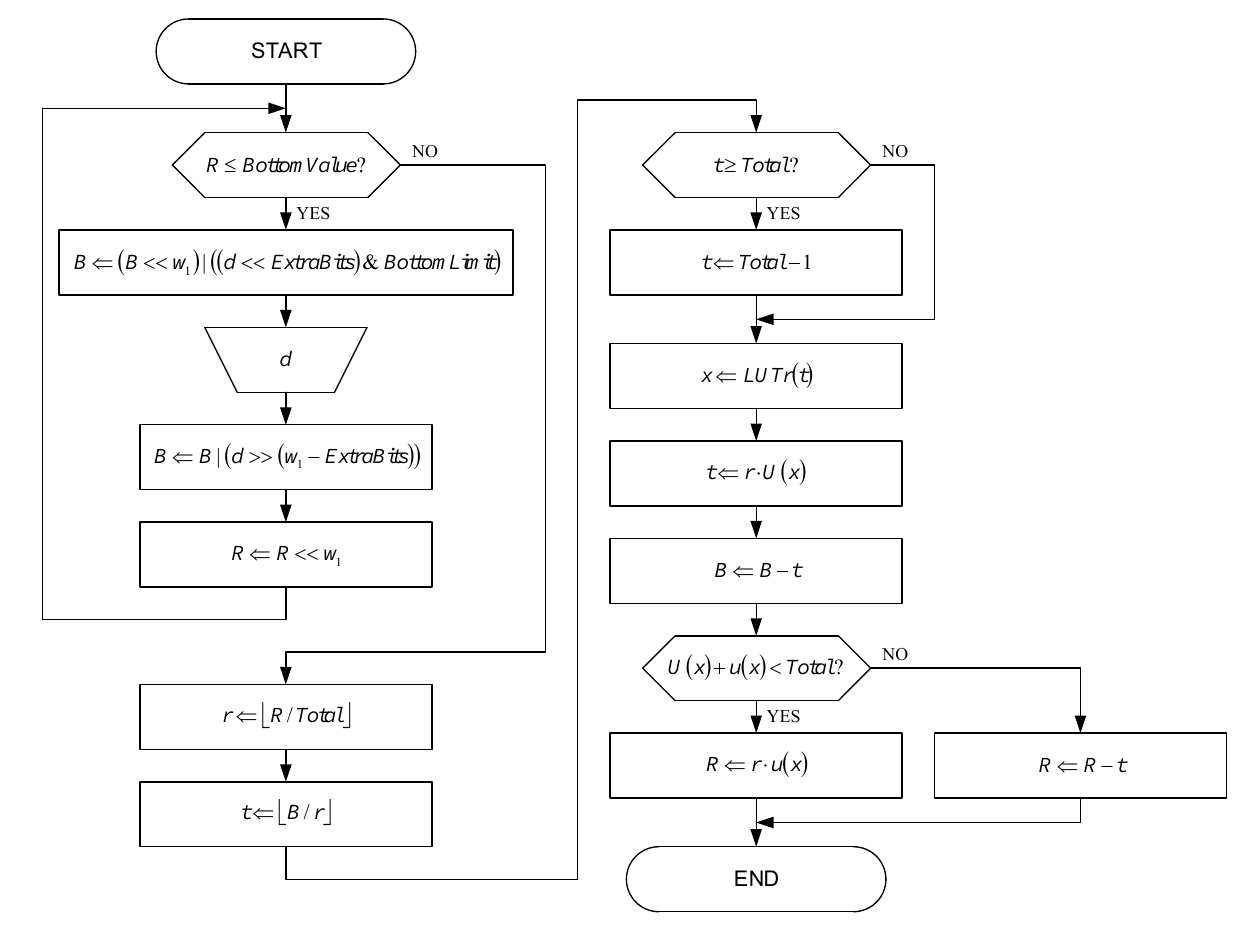
Figure 6. The flowchart of the state-of-the-art range decoder. Floating point range decoder algorithm after the renormalization and without